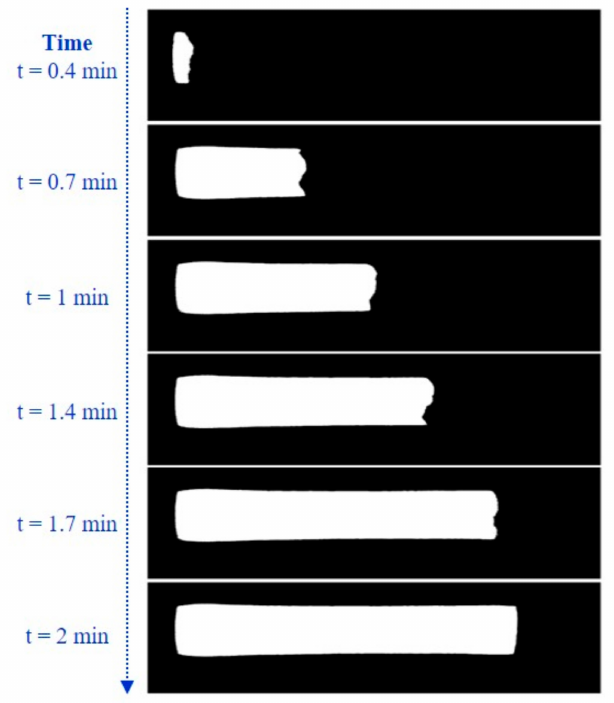
Figure 5. Binary maps obtained with time as the sample flow progresses through the NC